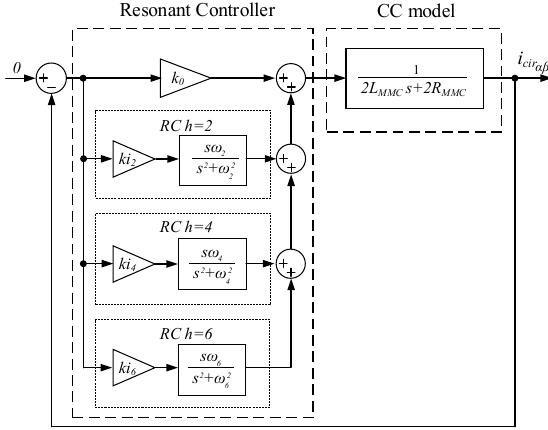
Figure 10. Proposed circulating current control scheme based on resonant controllers.